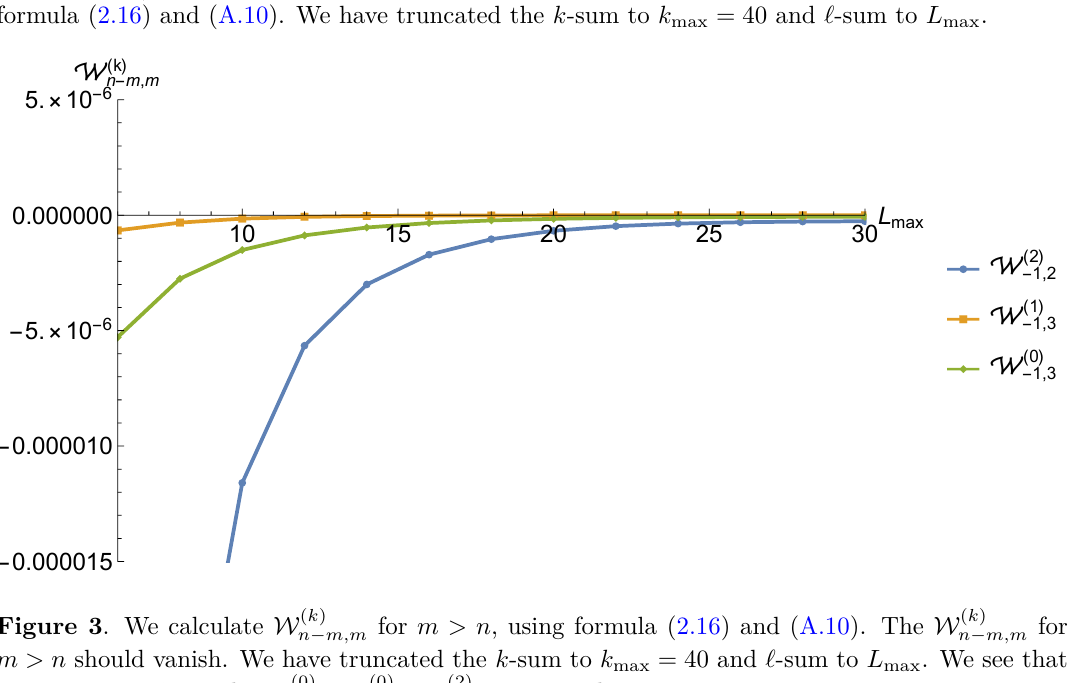
for m > n , using formula (2.16) and (A.10). The W ( k ) Figure 3 . We calculate W ( k ) n − m,m m > n should vanish. We have truncated the k -sum to k max = 40 and ‘ -sum to L max . We see that as we increase L the W (0) go toward zero. , W (0) , W (2) max − 1 , 3 − 1 , 3 − 1 , 2 powers of x as in the expression (2.14) due to locality. The coefficients W ( k )